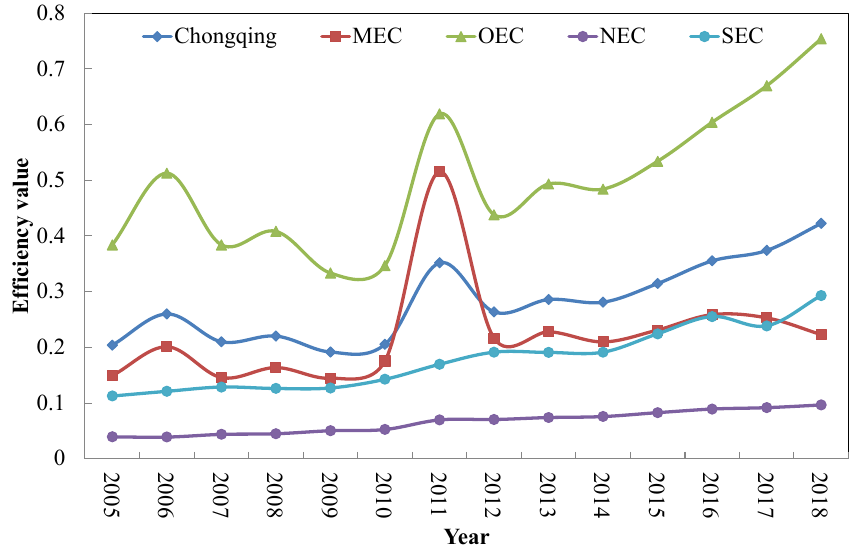
Figure 2. Temporal change in the RNCUE in Chongqing from 2005 to 2018.